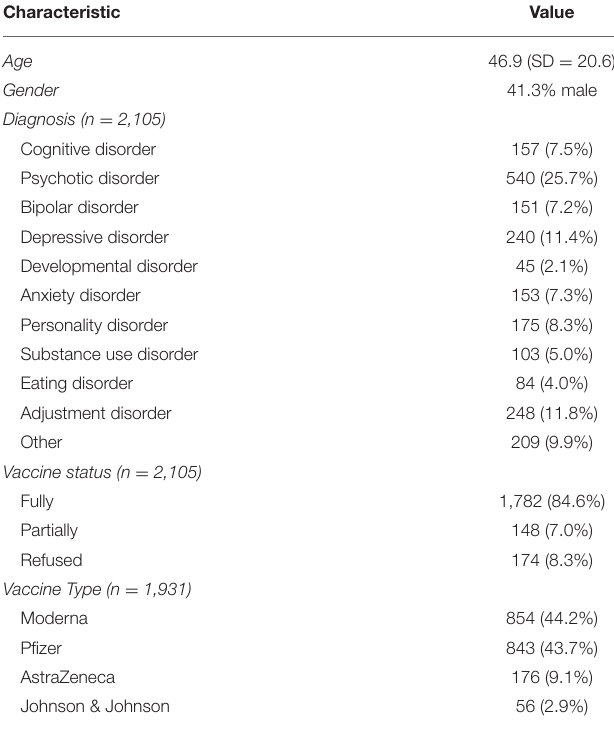
TABLE 1 | Demographic